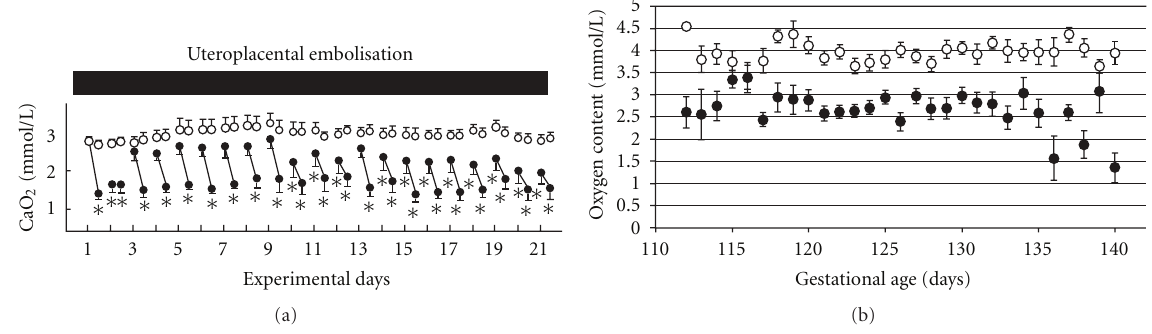
Figure 4: Fetal arterial oxygen content (mmol O 2 /L blood) in two sheep models of human IUGR. The uteroplacental embolisation model of IUGR in the sheep fetus results in periods of fluctuating hypoxemia over the 20-day experimental period starting at 110 days of gestation (a). In contrast, placental restriction (PR, n = 28; control, n = 31) in sheep (b) results in chronic hypoxemia that is maintained throughout late gestation [5]. Control, open circles UPE (a) or PR (b), closed circles. PR: placental restriction. The figure is reproduced in modified form with permission from [5, 111, 112].